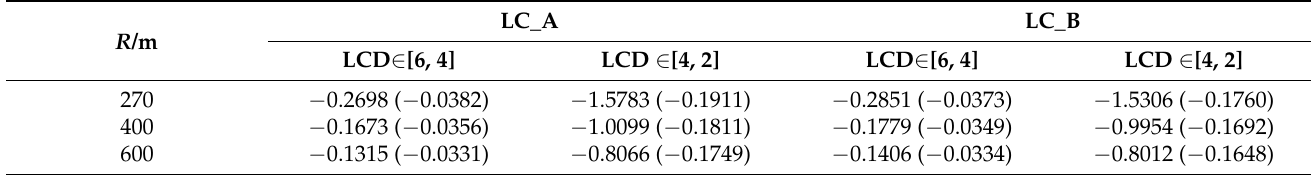
Table 5. Marginal effect of lane changing manipulation